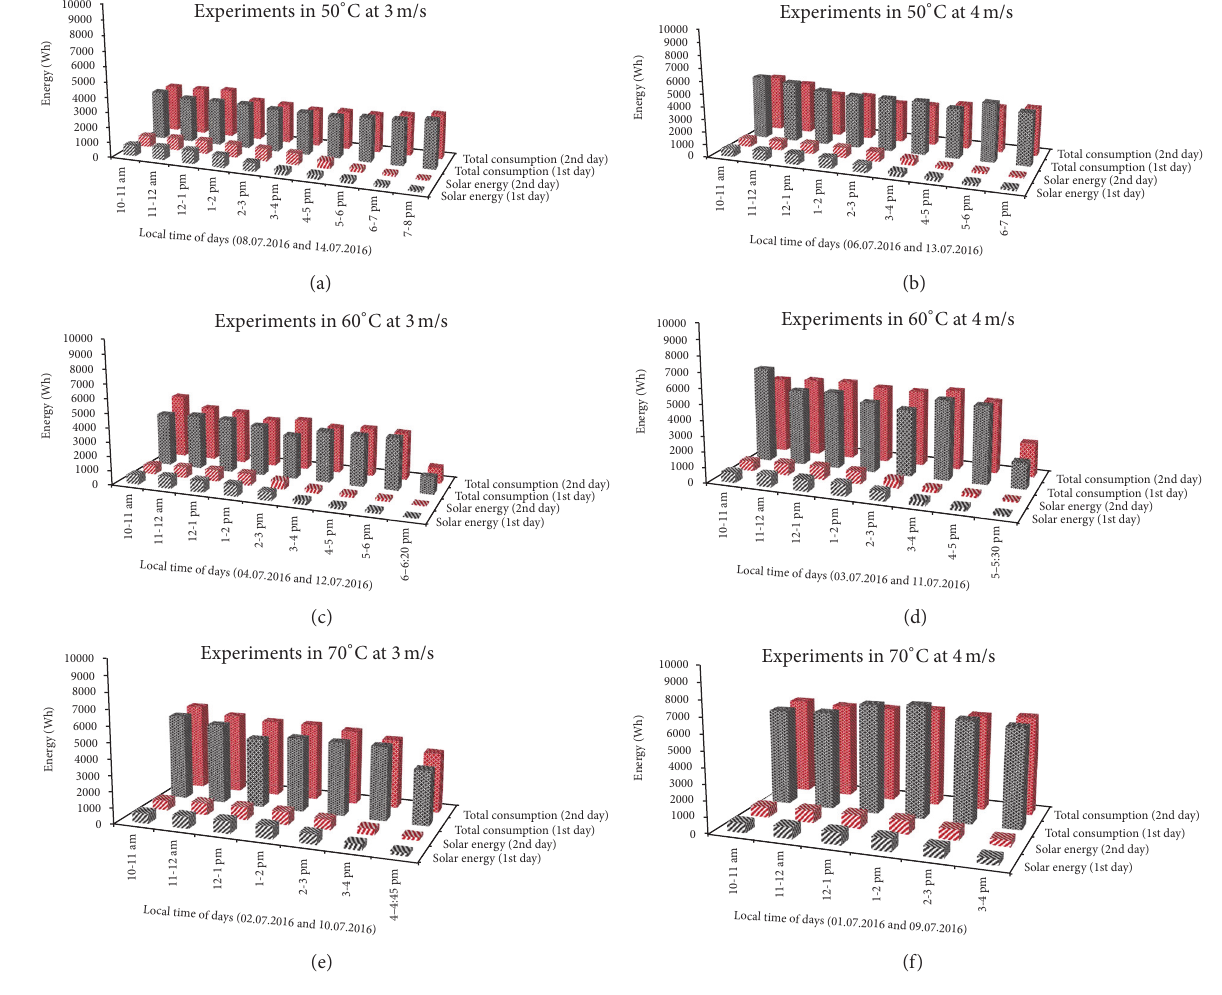
Figure 4: Energy consumption and energy